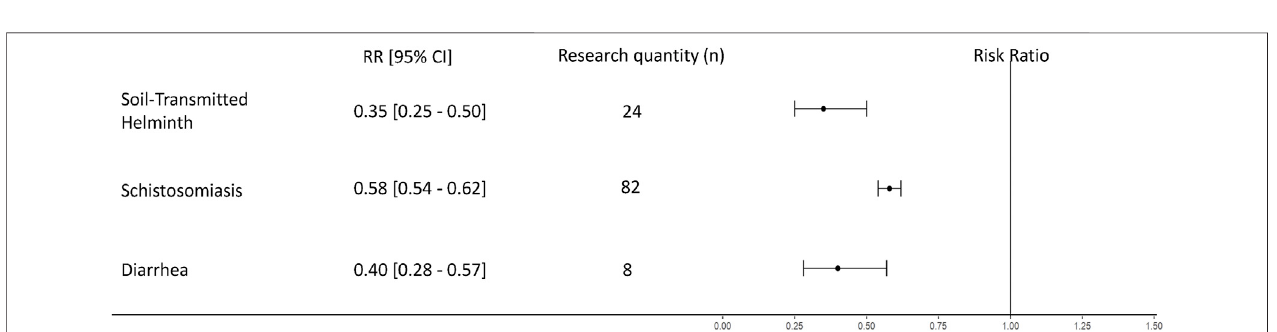
FIGURE 3 | Forest plot for schistosomiasis, diarrhea, and soil-transmitted helminths.